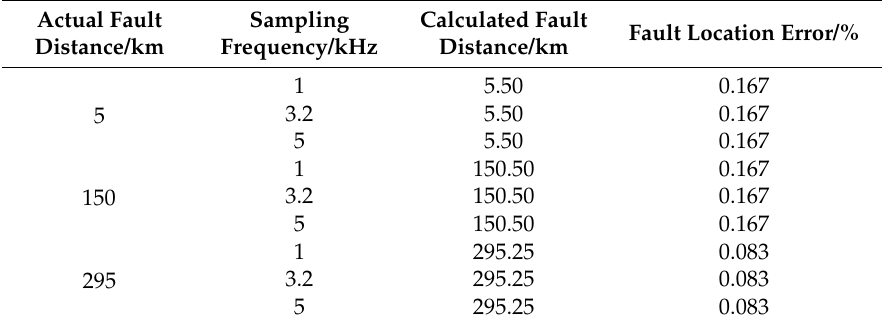
Table 2. Location error with different sampling